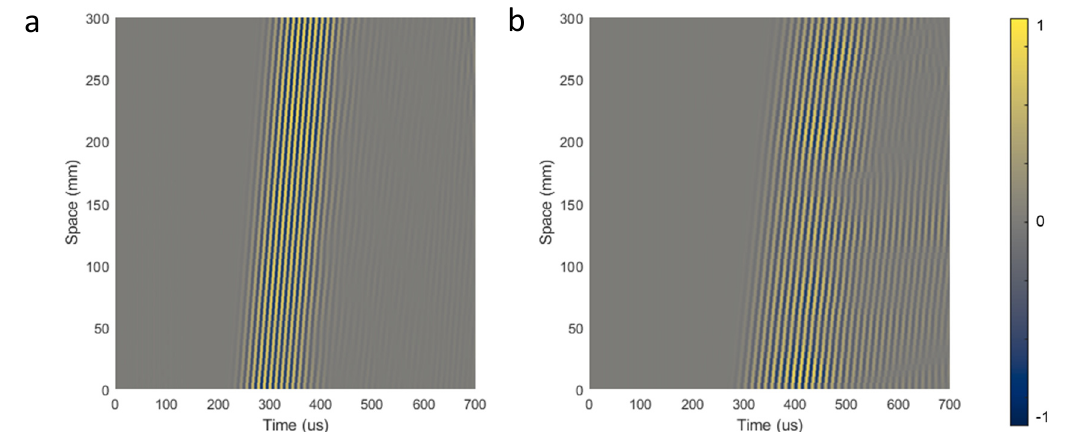
Figure 5. Mechanical wave propagation measurement results presented in the time ‐ space domain: (a) glass sample and (b) mortar sample. The measured signals using the ACT are normalized to have values from ‐ 1 to 1 where the amplitude of the signal, which represents a relative displacement, is represented by the color scale.